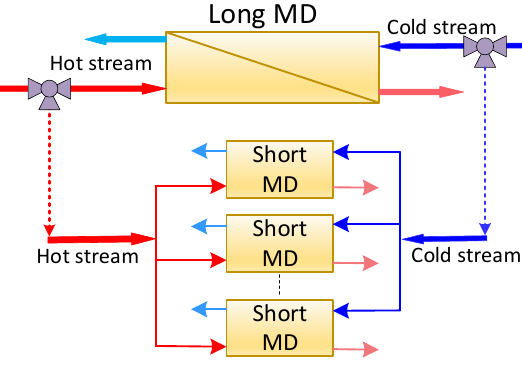
Figure 8. Short length MD configuration.